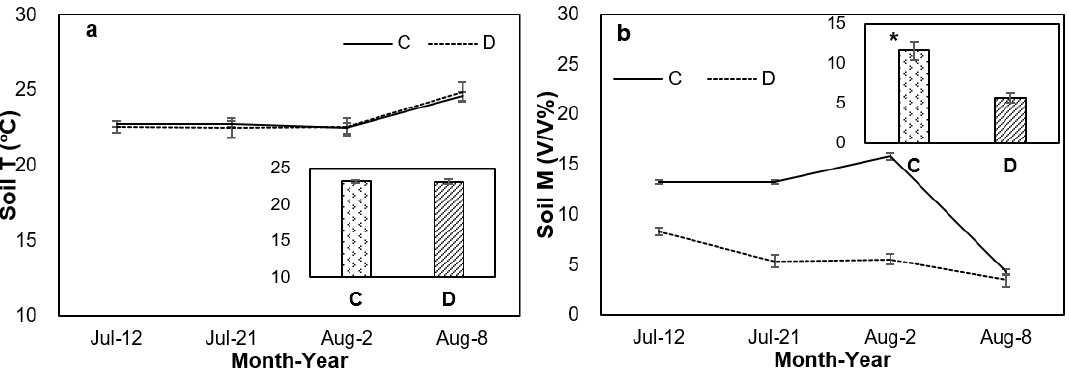
Figure 1. Dynamic variations of soil temperature (Soil T) on the 8 to 12 July to August in 2013, respectively. ( a , b ) are annual mean values ( ± SE). *, significant difference between the two treatments at the level p < 0.05. C: ambient precipitation; D: precipitation treatment; n = 6.